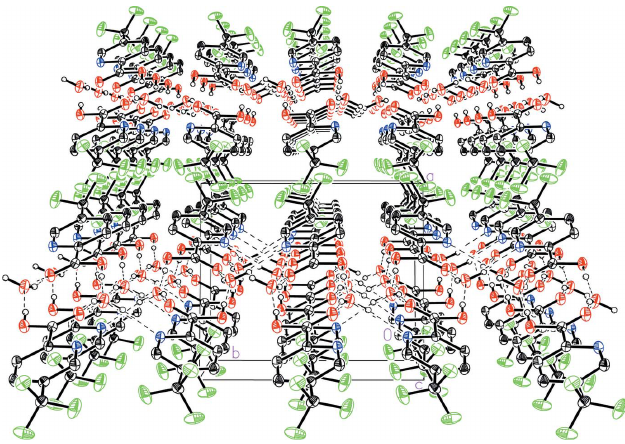
Figure 6 A view of the stacking of the two-dimensional sheets in 5-(trifluoro- methyl)picolinic acid (I) hydrate showing the trifluoromethylaromatic interactions at the interfaces of the